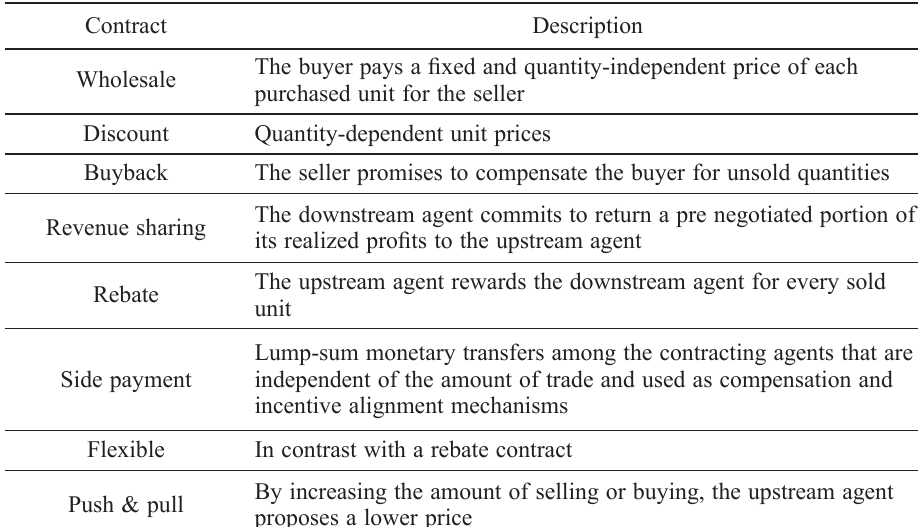
Table 1. Coordination